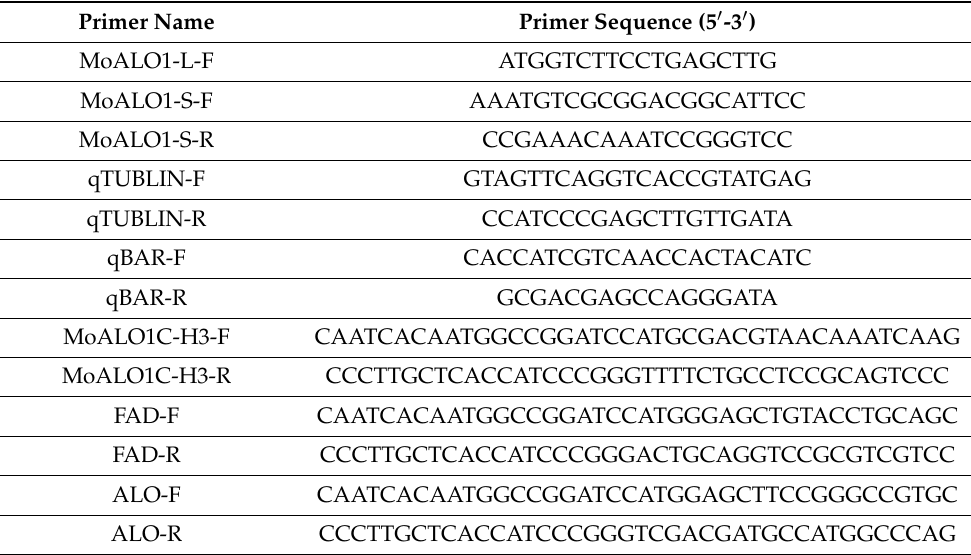
Table A1. Cont. Primer